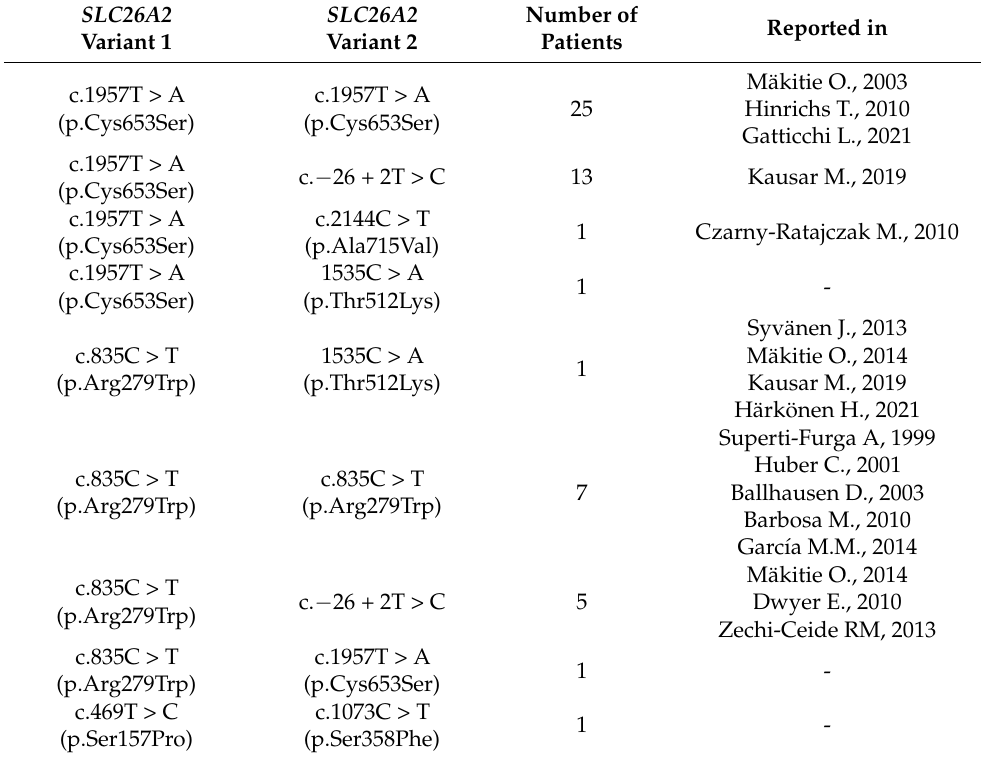
Table 2. The spectrum of identified variants in the SLC26A2 gene of Russian patients with MED type 4.